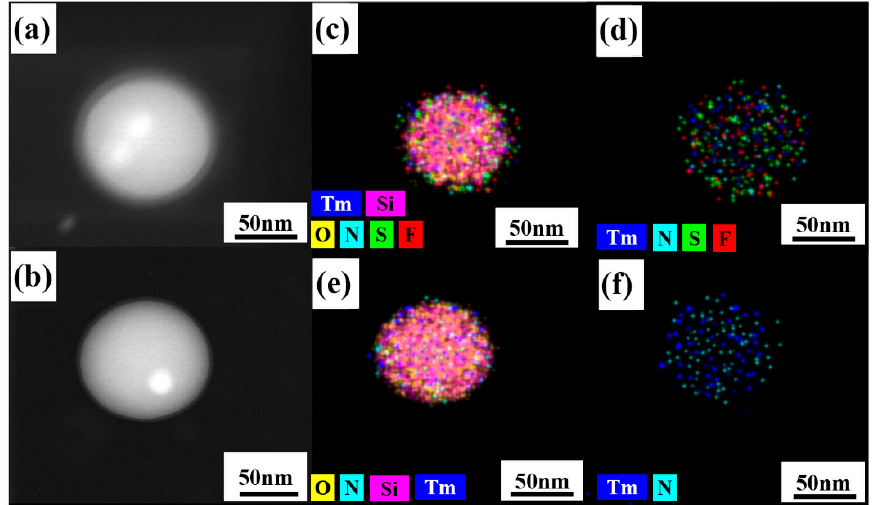
Figure 4. Scanning transmission electron microscopy (STEM) dark-field (DF) image of ( a ) SiO 2 -Tm(TTA) 3 phen and ( b ) SiO 2 -Tm(DBM) 3 phen; ( c , d ) elemental mapping of Si, O F, S, Tm, and N elements of SiO 2 -Tm(TTA) 3 phen; ( e , f ) elemental mapping of Tm, Si, O, and N elements of SiO 2 -Tm(DBM) 3 phen.